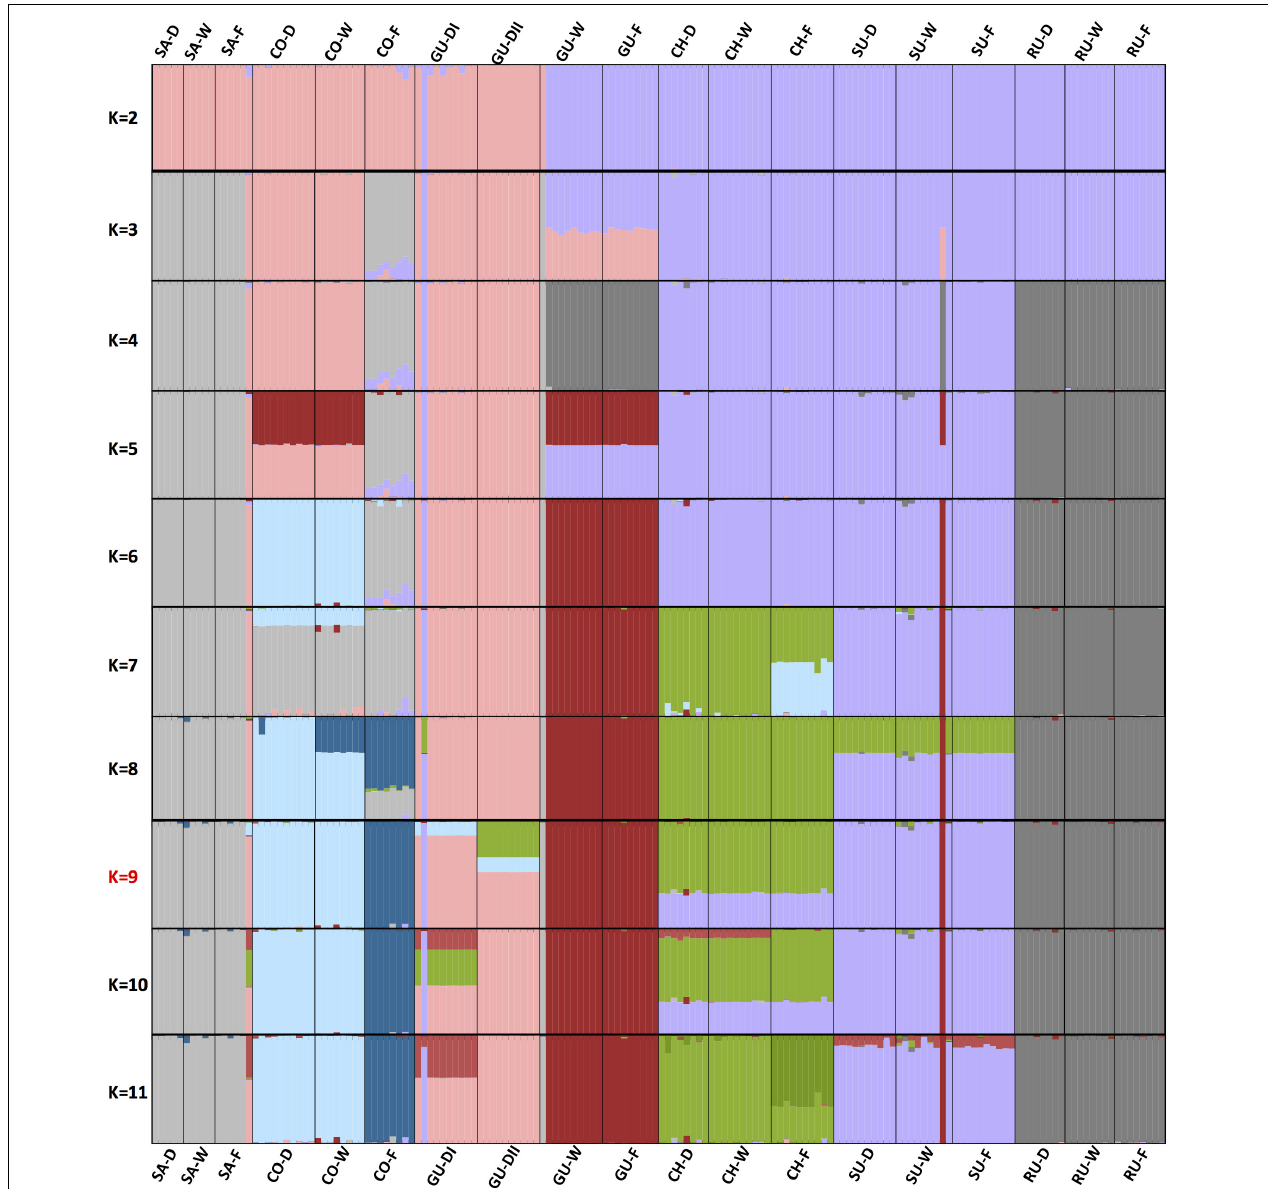
FIGURE 3 | Population structure from assignment tests in STRUCTURE based on 1,273 variable SNP markers. K -values of 2–11 populations are shown. The optimum K -value ( K = 9, Supplementary Figure S2 ) according to Evanno et al. (2005), the PCoA ( Figure 2 ) and visual inspection is marked in red. Populations are sorted from north to south with the only locality from the Colombian Central Cordillera at the extreme right. The name of each population is given at the top of the bar plot and the localities and ecotypes are colored and coded as in Figure 1 .